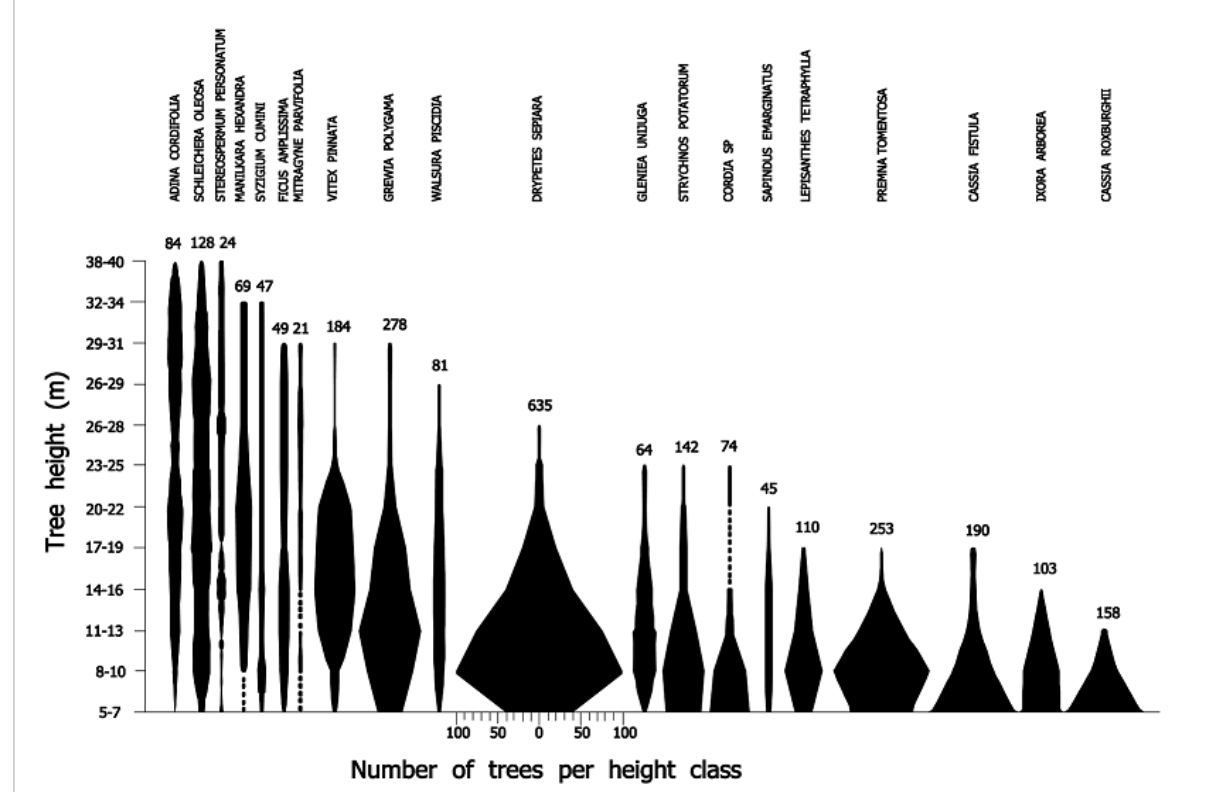
Figure 6: Cross section of a typical dry monsoon forest habitat for dry zone mammals, as at Polonnaruwa, Sri Lanka, indicating the distribution of the major tree species according to the frequency of numbers of trees by their height. (After Dittus,